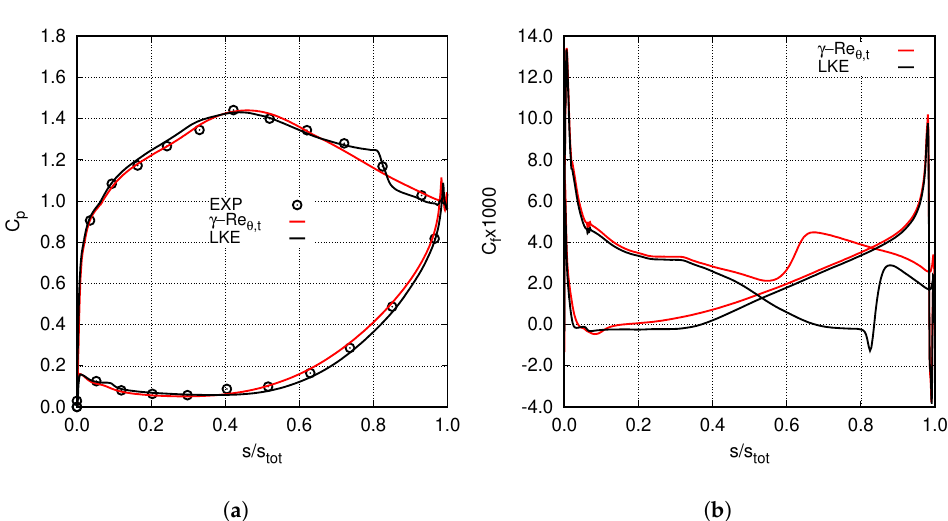
Figure 3. Blade surface distributions of ( a ) pressure-coefficient ( b ) skin friction ( Re 2, is = 3.0